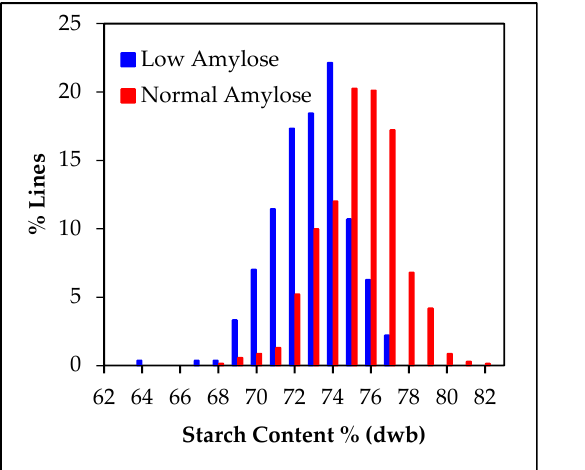
Figure 9. Variability of NIR predicted dry weight basis starch and protein contents in the low amylose (Amylose < 5%) and normal amylose (Amylose > 15%) grain samples of the two breeding populations.